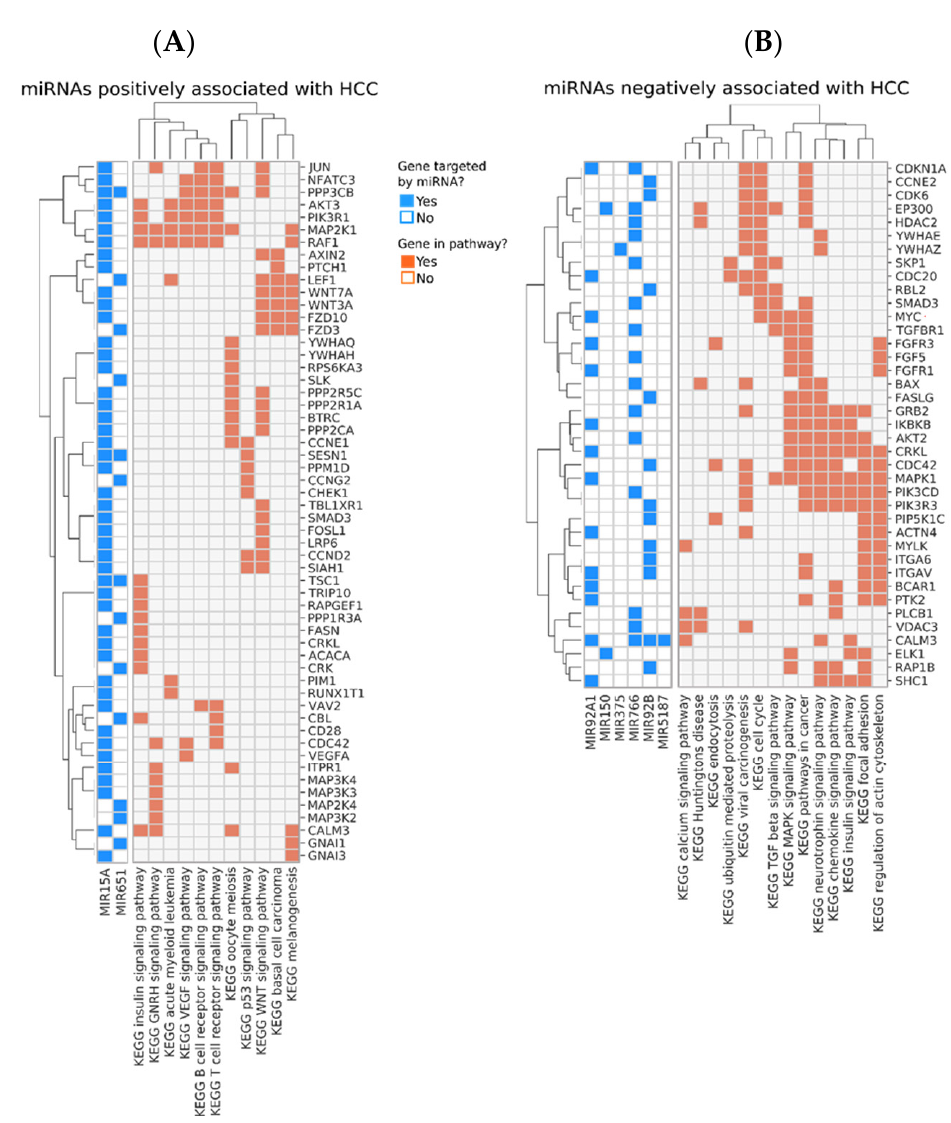
Figure 6. Pathways positively ( A ) or negatively ( B ) associated with the subsequent development of HCC. Genes targeted by the miRNAs are shown in rows. The annotation matrix to the left matches each miRNA (shown at the bottom left ) with the genes they regulate (shown in rows). The annotation matrix to the right matches each gene to the most enriched pathways they participate in, which are shown at the bottom.